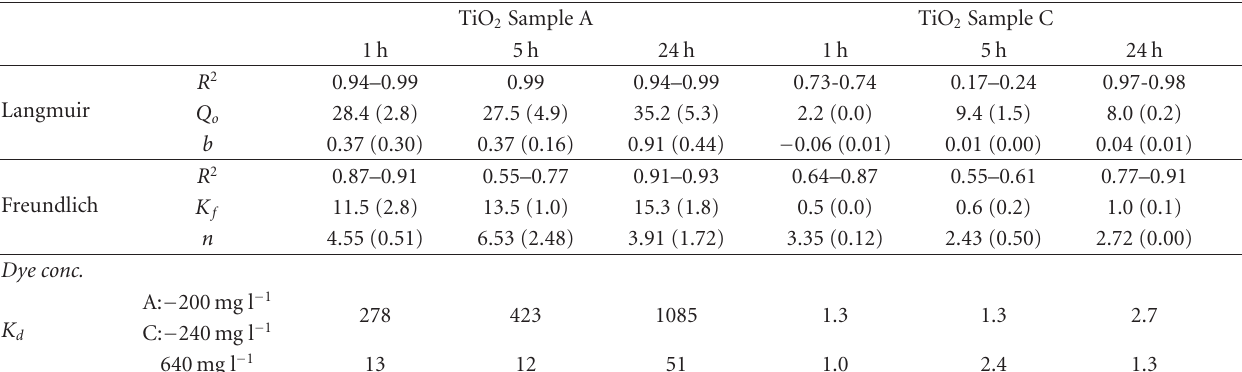
Table 2: Langmuir and Freundlich isotherm data and partition coe ffi cients for TiO 2 samples A and C at 1, 5, and 24 hours. For R 2 , the range of values is shown from the replicate experiments. For other parameters, the data shown are averages with standard errors in